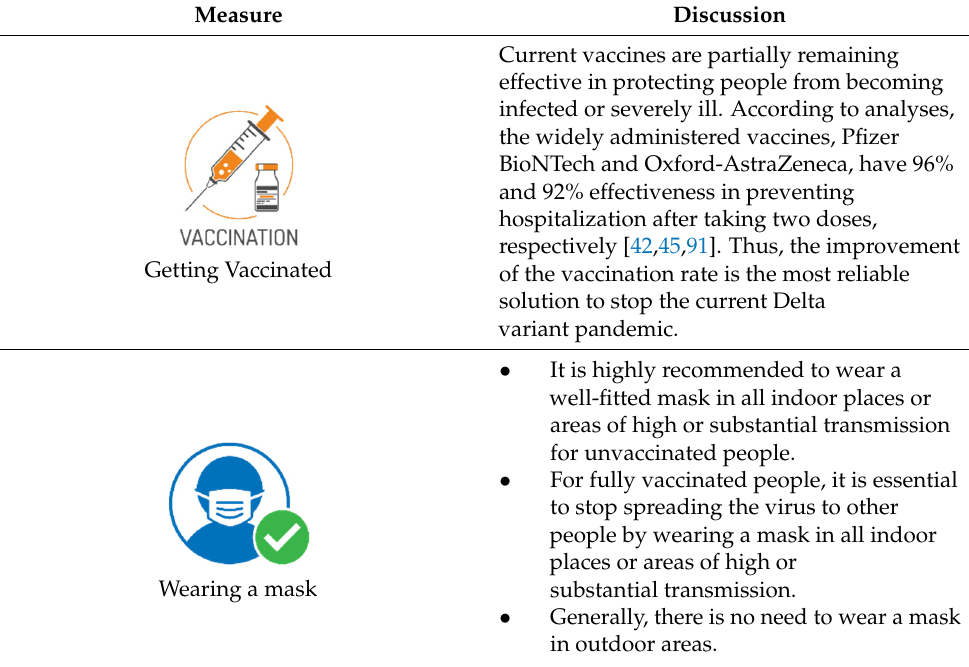
Table 3. Delta variant preventive measures.